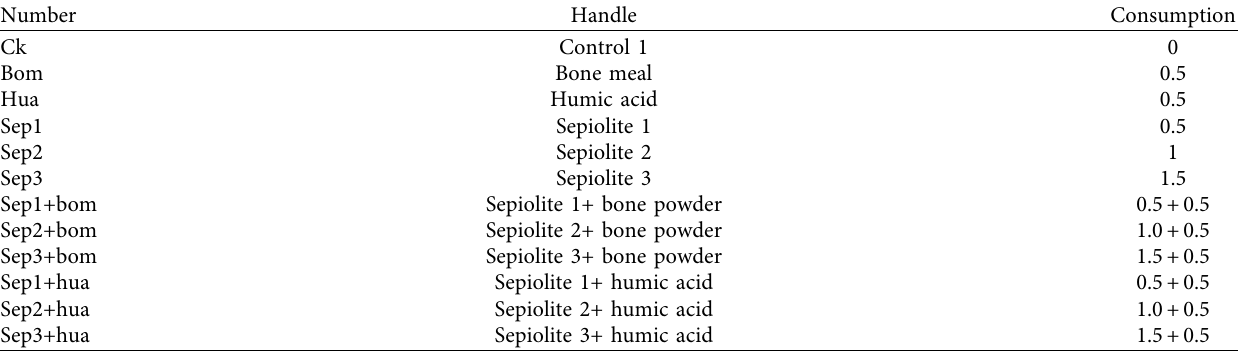
Table 5: Experimental treatment of passivation